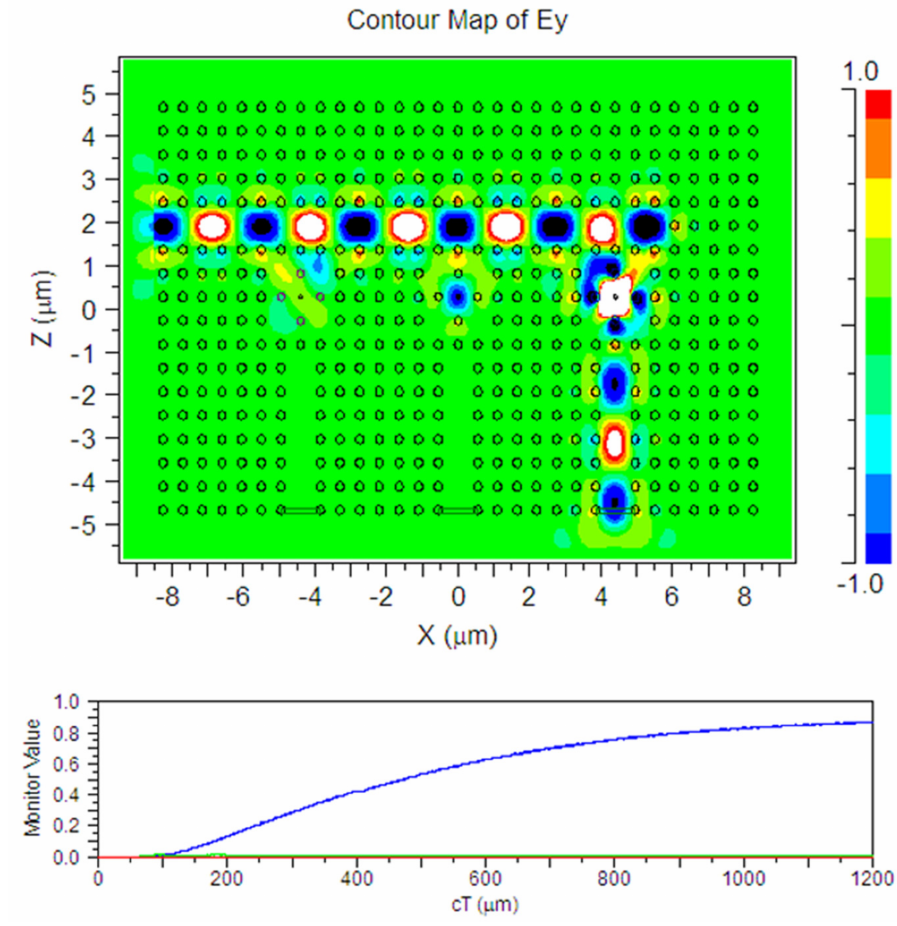
Figure 4. Distribution of Ey at λ = 1.5938 µ